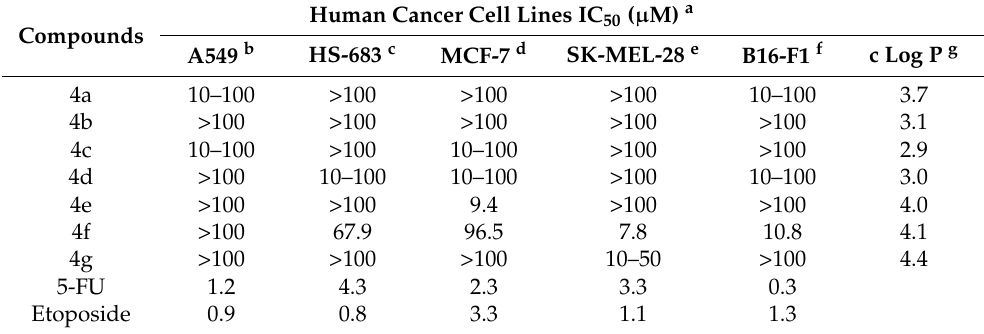
Table 2. The cytotoxic activities of the synthesized compounds and standard anticancer agents expressed in terms of IC 50 ( µ